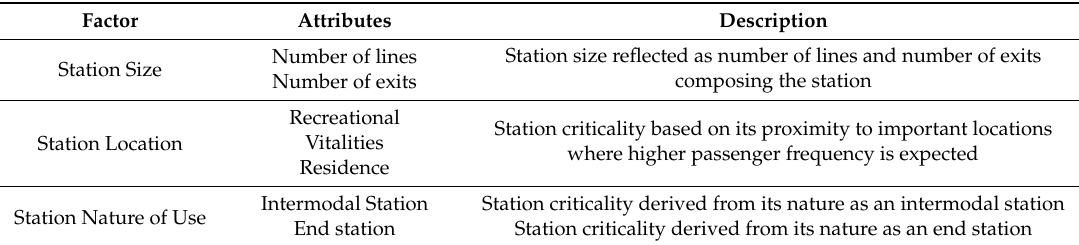
Table 9. Subway Systems Criticality Attributes [25].